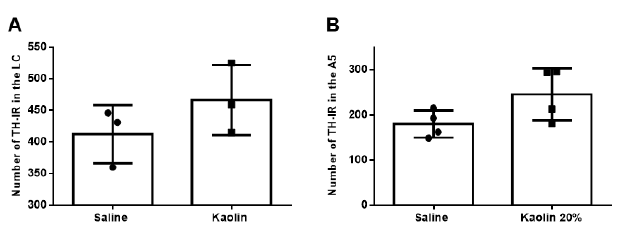
Figure A2. Mean numbers of TH-IR neurons in the LC ( A ) and pontine A 5 noradrenergic cell group ( B ) of saline- and kaolin-injected animals. Counting of LC neurons was performed in immunofluorescence sections like those of Figure 4 since accurate identification cannot be performed in DAB-stained material. No statistically significant differences were detected between the 2 groups. Saline n = 3; Kaolin n = 3 in ( A ). Saline n = 4; Kaolin n = 4 in ( B ).